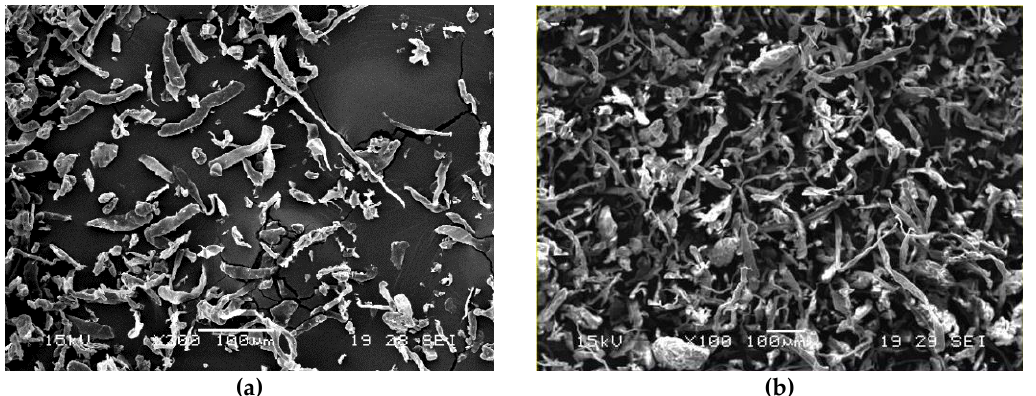
Figure 6. Scanning Electron Microscope (SEM) micrograph showing micro-cellulose fibers before processing: ( a ) Arbocel ® 600BE7PU and ( b ) Arbocel ® BWW40.